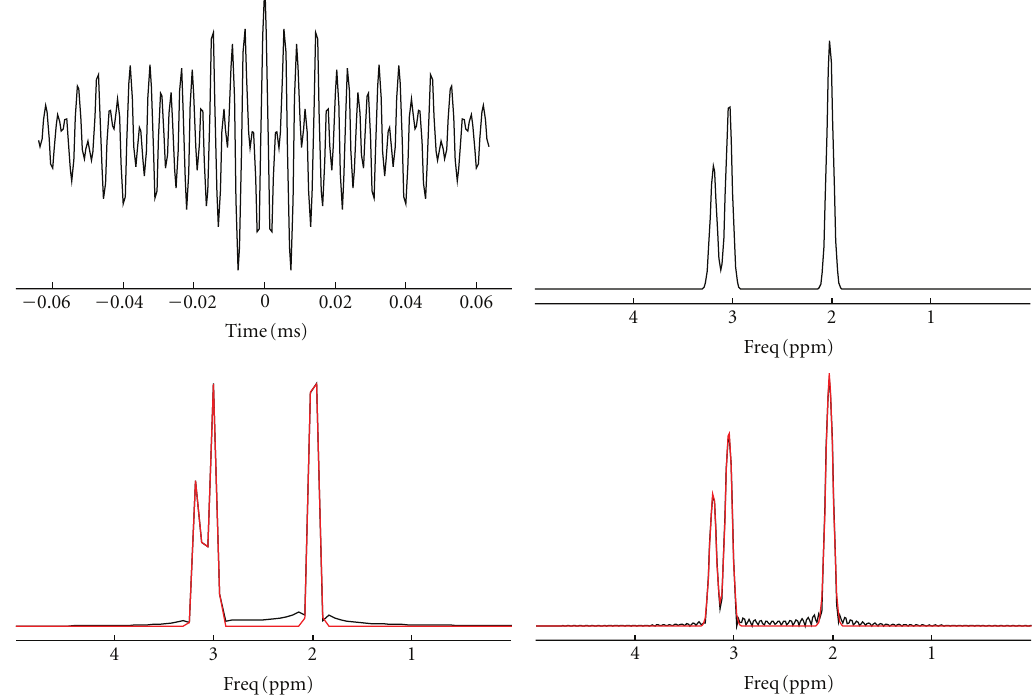
Figure 2: Simulated echo with 256 data points and its spectrum obtained with 1024 data points (upper). The time and frequency domain fitting algorithms can fully recover each of them. However, when fitting the spectrum with 256 data points, or when the spectrum was zero- filled from 256 to 1024 data points, sizeable errors are evident as a consequence of either low spectral resolution or truncation e ff ects, which manifest as wiggles in the spectrum after zero-filling (lower).